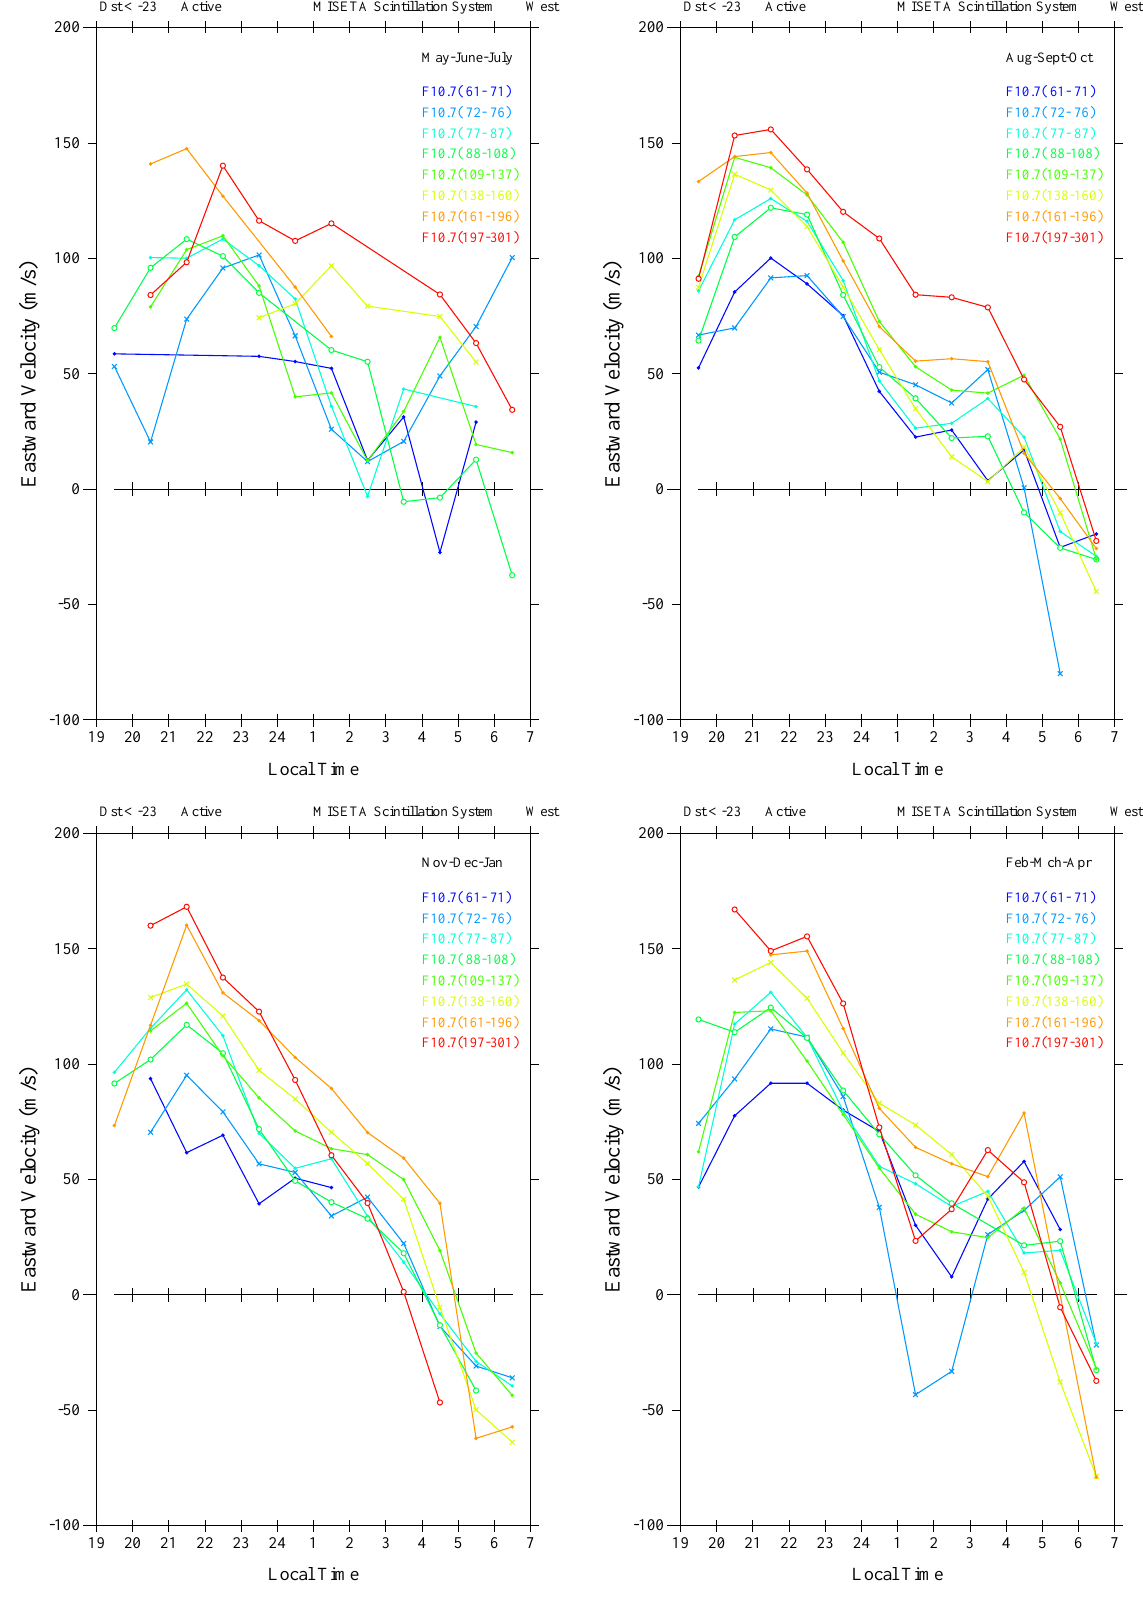
Fig. 5. (a) Seasonal average zonal drifts for Ancon-W, active D st ( < −